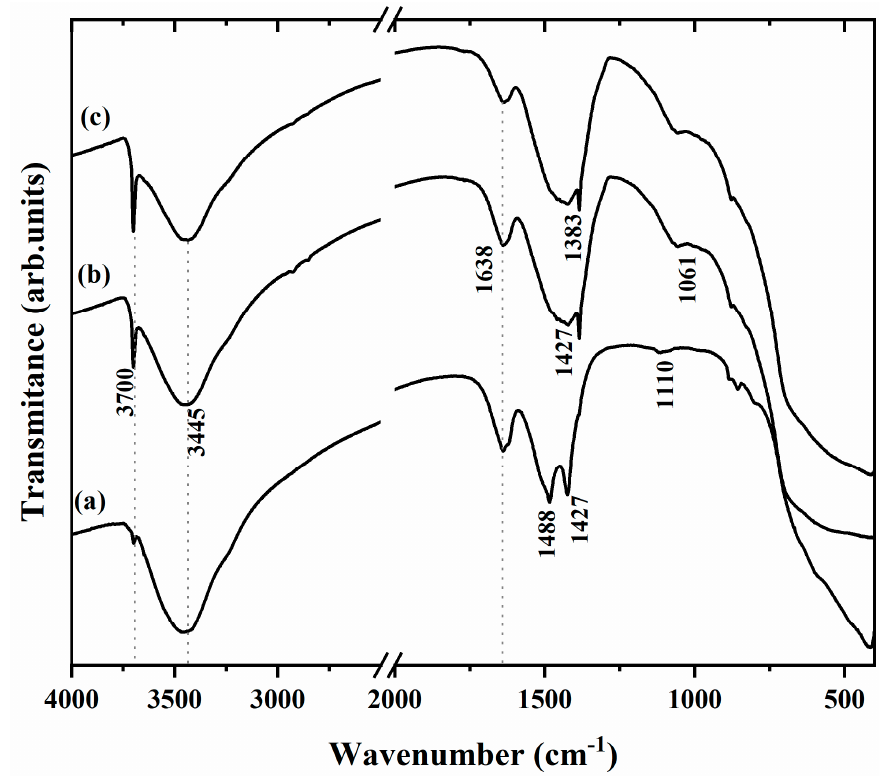
Figure 2. FTIR spectra for the samples ( a ) MgO-St, ( b ) MgO-CP, and ( c ) MgO-Av.